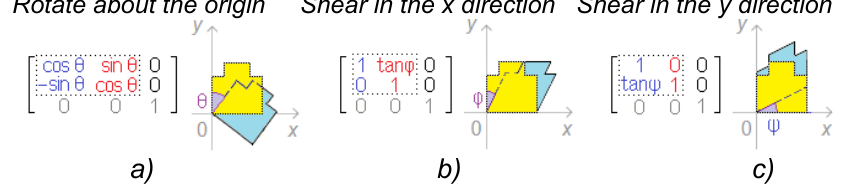
Figure 3 – Transformation matrices and the results of their impact on the chest target: a – rotation; b – horizontal shearing; c –vertical shearing Рис . 3 – Матрицы трансформации и результаты воздействия на грудную